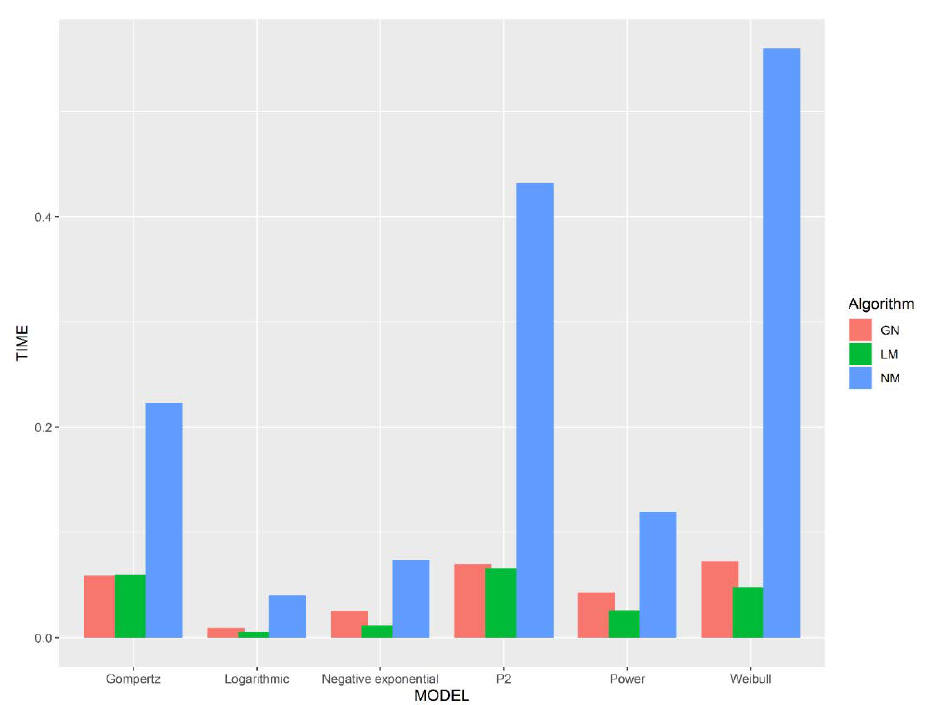
. GN represents the Gauss–Newton method, LM represents the Levenberg–Marquardt to method, and NM represents the Nelder–Mead method. 𝑥𝑥 𝑇𝑇